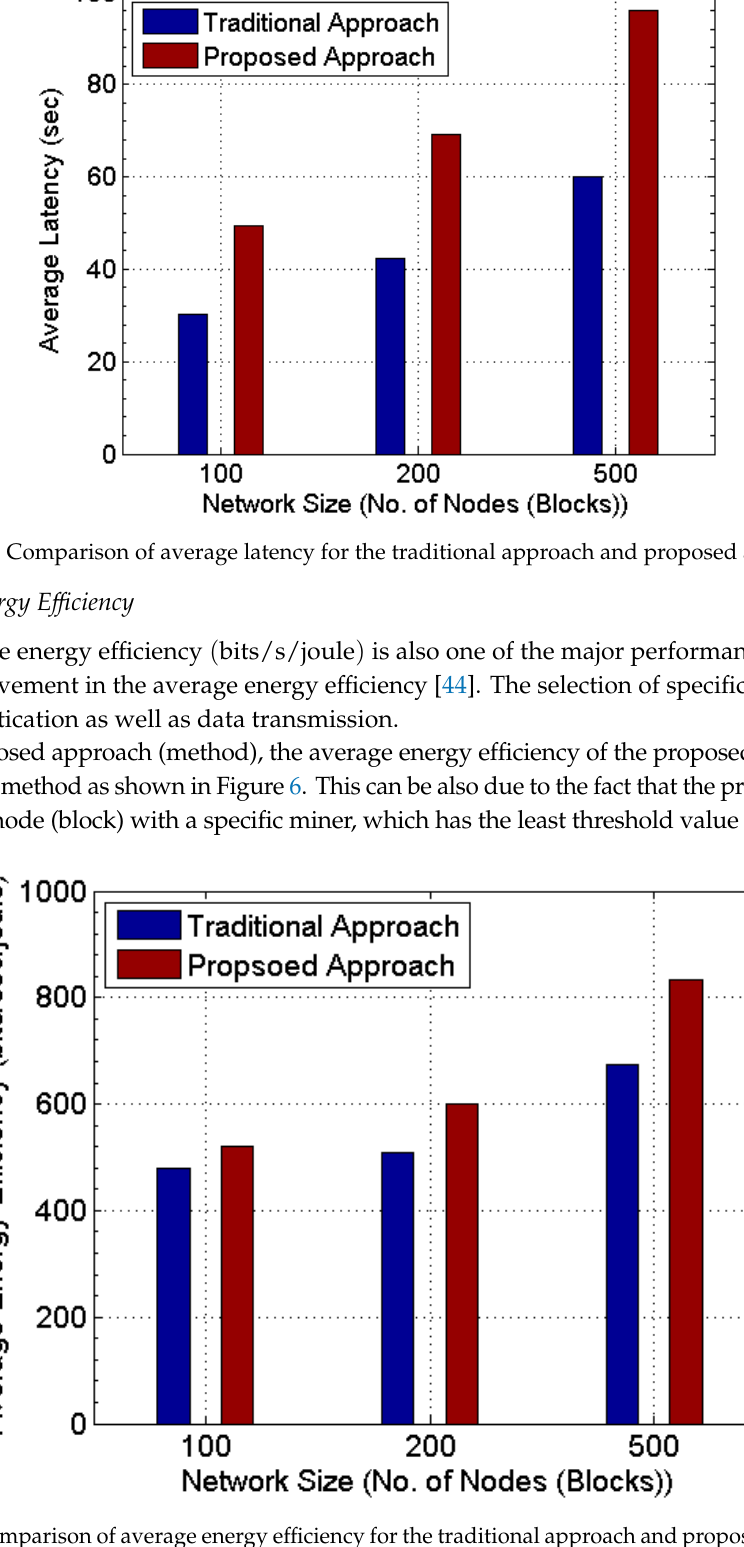
Figure 6. Comparison of average energy e ffi ciency for the traditional approach and proposed